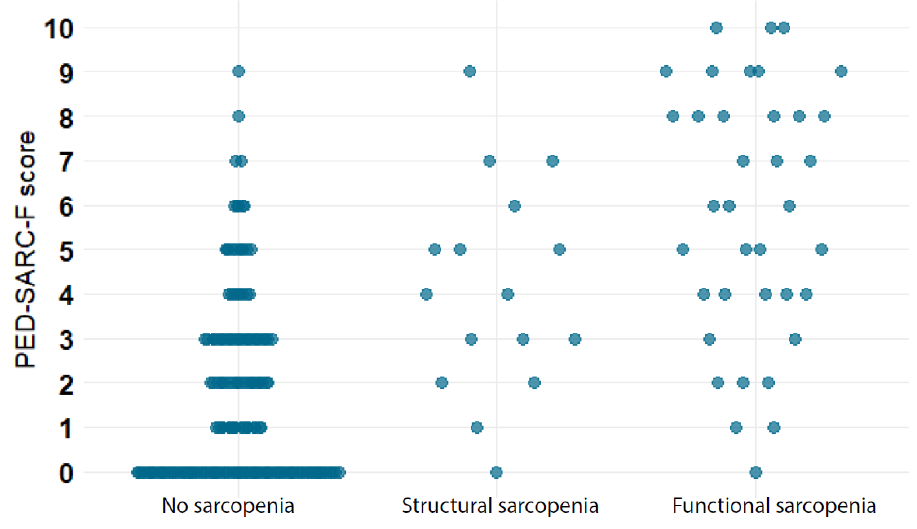
Figure 3. Scattergraph: No, structural and functional sarcopenia by PED-SARC-F score. Table 3. The predictive accuracy of the PED-SARC-F for detecting functional and structural sarcopenia. OR 95% CI AUC (95%